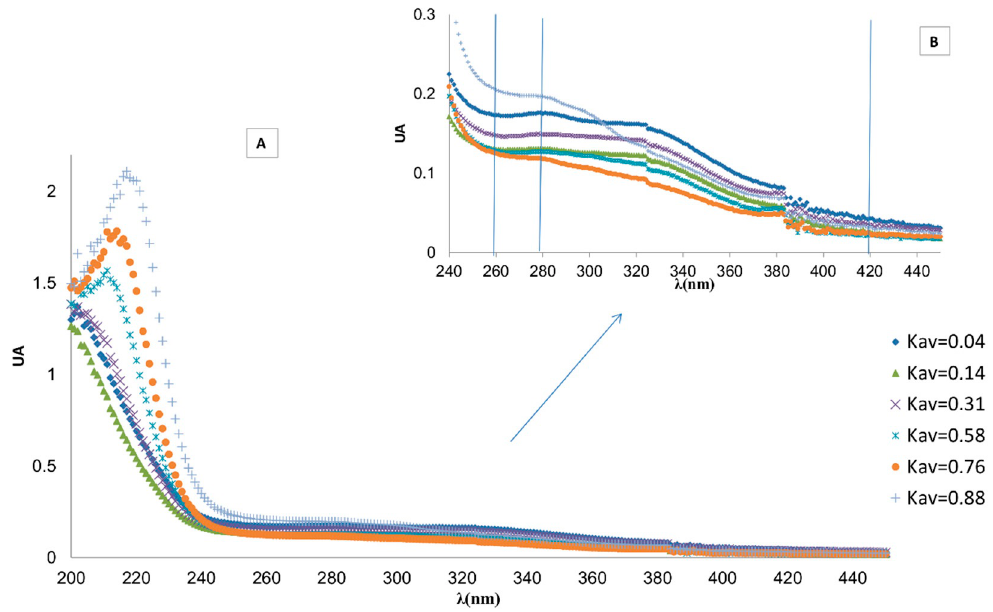
Figure 6. UV-VIS spectra of different melanoidins from IHS fractions isolated by SEC chromatography on a Biogel P2 column ( A ). Insert ( B ): expansion of the UV spectra.